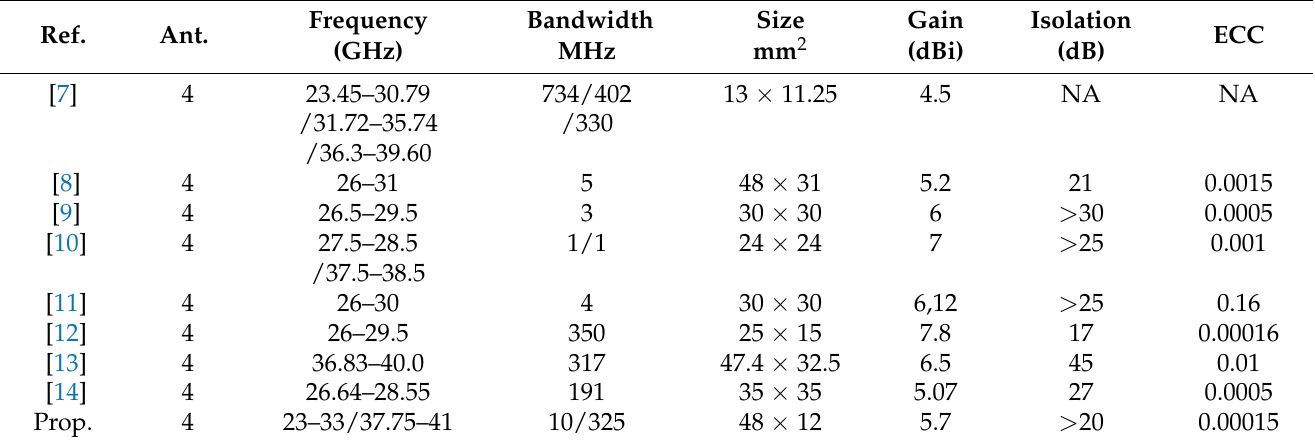
Table 2. Comparison of the proposed antenna system with the